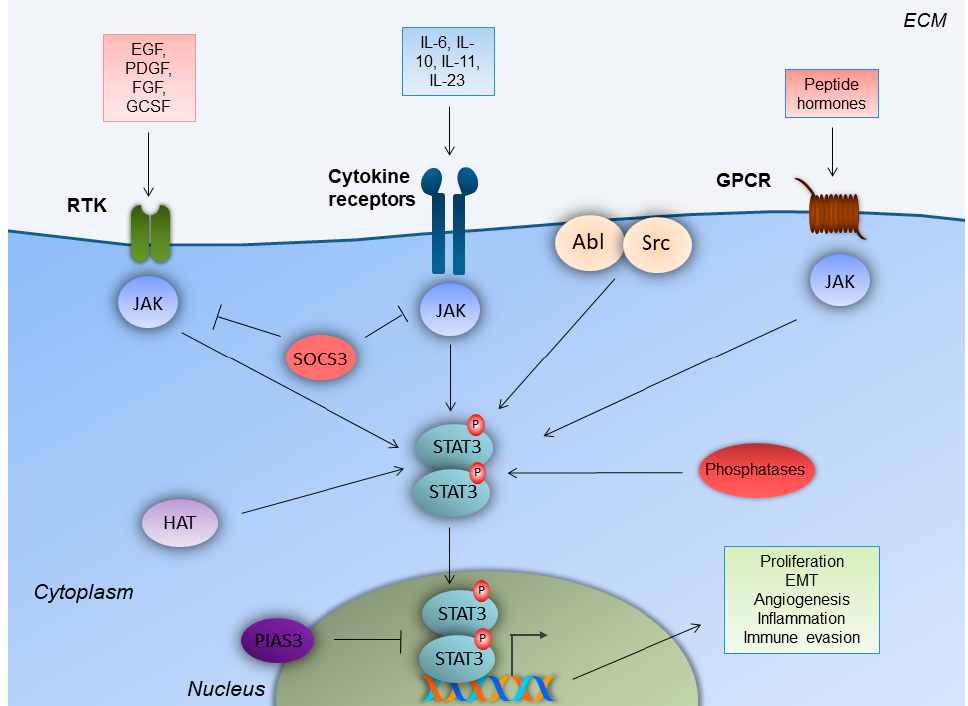
Figure 1. STAT3 signaling in colorectal cancer cells. Upon ligand binding, receptor tyrosine kinases (RTK), cytokine receptors and G-protein-coupled receptors (GPCR) lead to Janus kinase (JAK) recruitment, which facilitates signal transducer and activator of transcription-3 (STAT3) phosphorylation and homodimerization. STAT3 homodimers enter the nucleus and enhance gene transcription to induce colorectal cancer cell-specific properties. Regulation of STAT3 is achieved by non-receptor tyrosine kinases (Src, Abl), histone acetyltransferases (HAT), tyrosine phosphatases and E3 SUMO-protein ligase (PIAS3). Epidermal growth factor receptor (EGFR); extracellular matrix (ECM); fibroblast growth factor receptor (FGFR); granulocyte colony-stimulating factor receptor (GCSFR); platelet-derived growth factor receptor (PDGFR); suppressor of cytokine signaling 3 (SOCS3) .